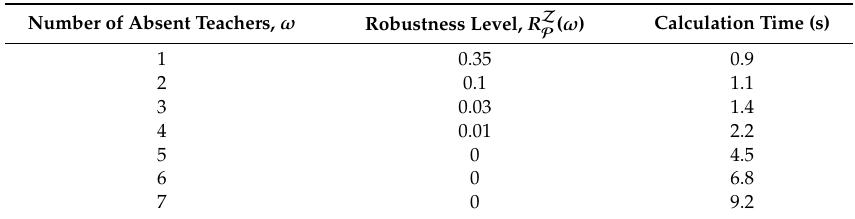
Z ( ω ) , of FECS competency framework (Table 6). P